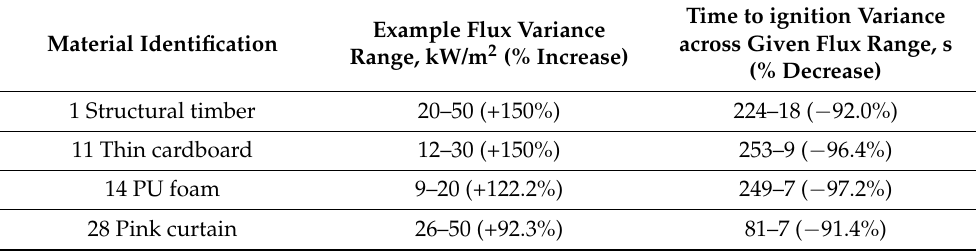
Table 3. Example materials from informal settlements that show a high degree of flux-sensitivity [38].